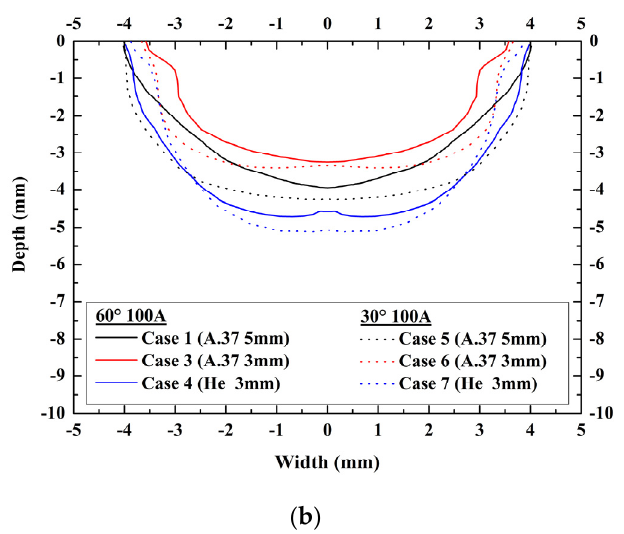
Figure 7. ( a ) Effect of the tip angle on the evolution of the weld pool shapes; ( b ) Effect of the tip angle on the depth ‐ to ‐ width ratio.